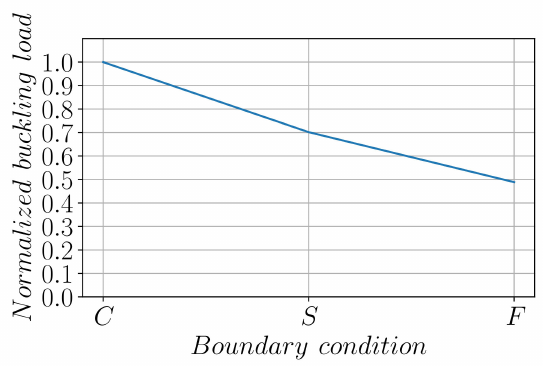
Figure 3. Normalized buckling loads for different boundary